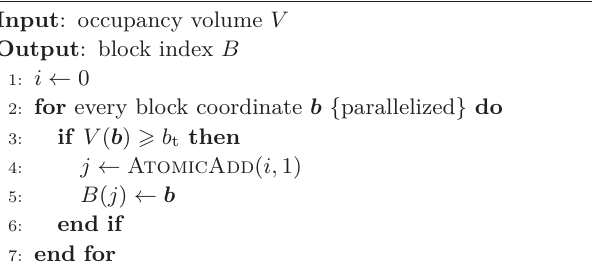
Algorithm 2 Block list generation